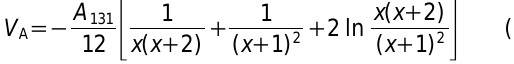
(cid:2) 44%, f (cid:2) O are f 2 3 d p , f and f values d p h